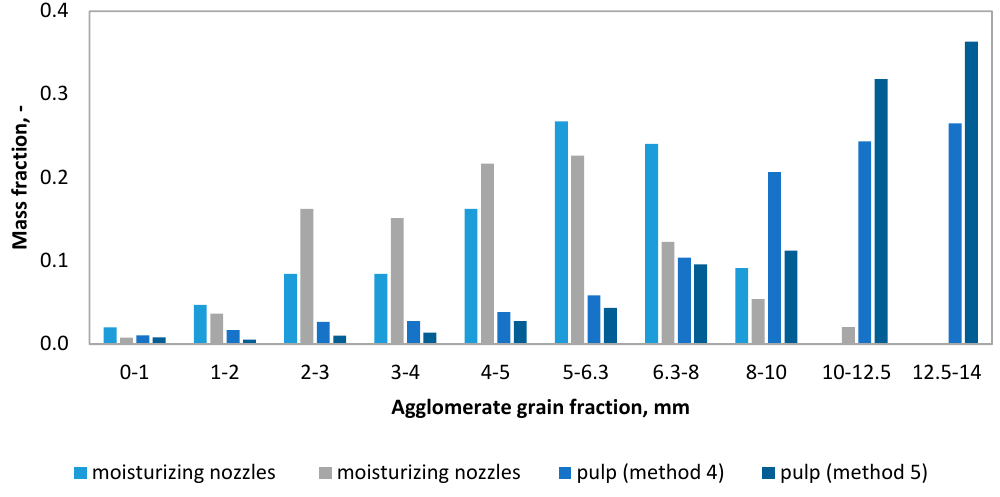
Figure 6. Comparison of disc granulation methods with the addition of dolomite.